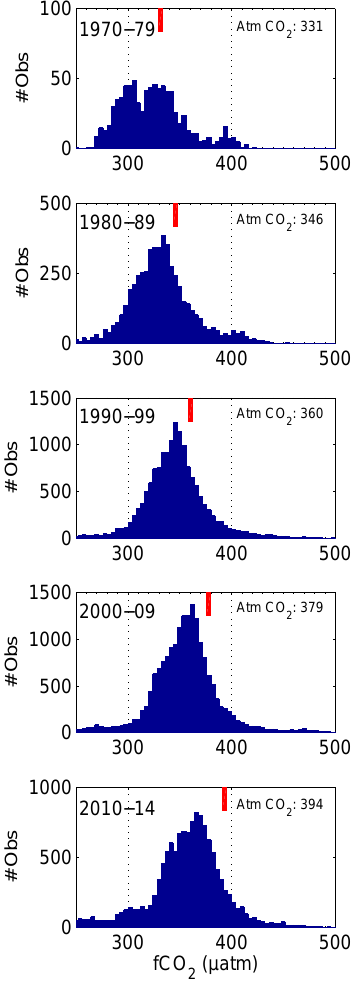
Figure 5. Bar plots of the number of decadal mean f CO 2 values per 4µatm range for data-set-weighted gridded f CO 2 values in ver- sion 3. Red bars indicate the mean atmospheric value (µmolmol − 1 ) at Mauna Loa, Hawaii, for each decade (Tans and Keeling, 2016). Note the changing scale on the y axis. Similar figures have been made for versions 1 and 2 (Olsen et al., 2013; Sabine et al., 2013).